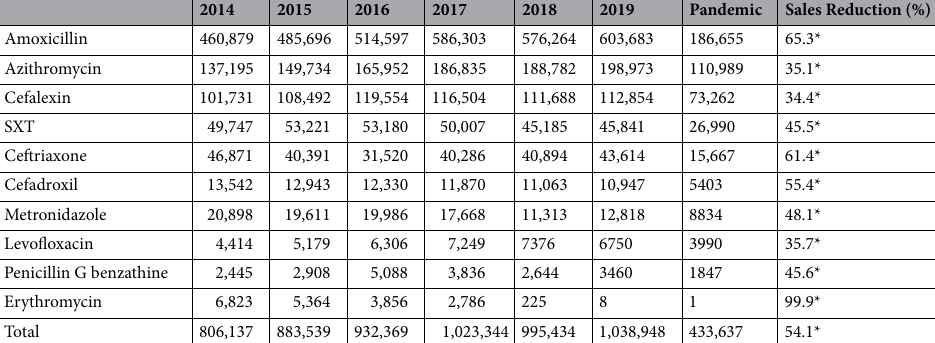
Table 1. Monthly average of commercial units of antibiotics sold in Brazil for children aged 1–12 years, between 2014 and 2019 and during the pandemic period (Jan 2020 to July 2021). *Statistically significant reduction – ( P < 0.0001). Dunnett Multiple Comparisons Test. SXT – (sulfamethoxazole and